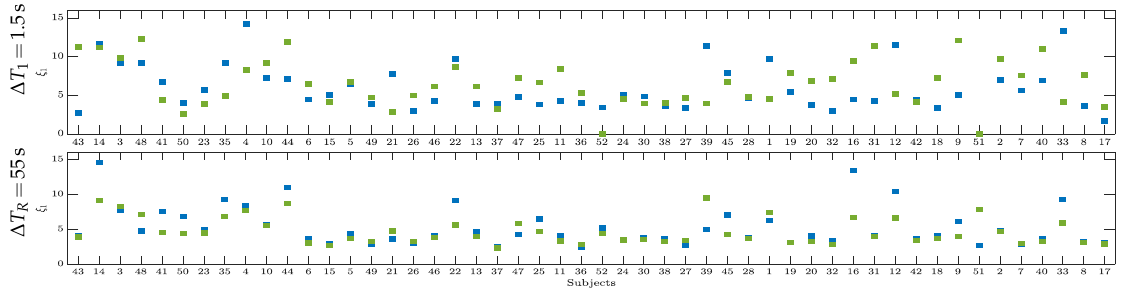
Figure 5. Pre-training desynchronization indicator ξ 1 computed for baseline inverval (top plot) and resting data (bottom row) while using either electrode arrangement: 2Ch (blue color) and 6Ch (green color). Individuals are ranked according with the achieved accuracy response.